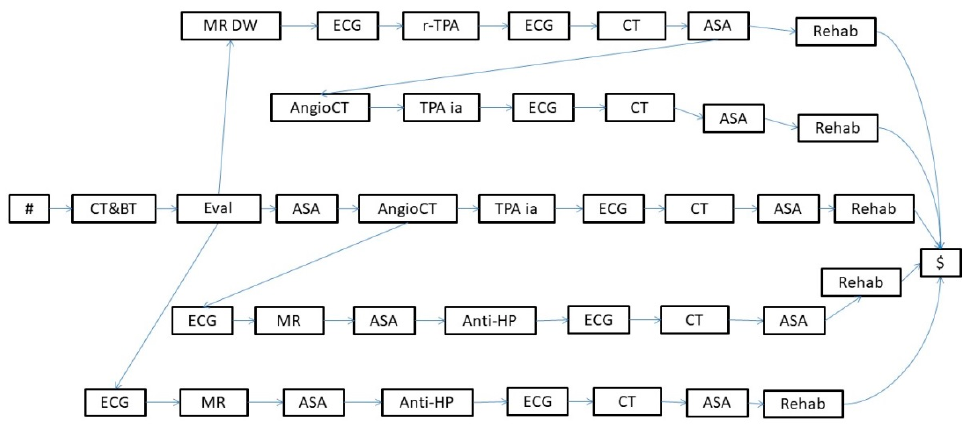
Figure 1. The starting process model (log tree) of our running example.